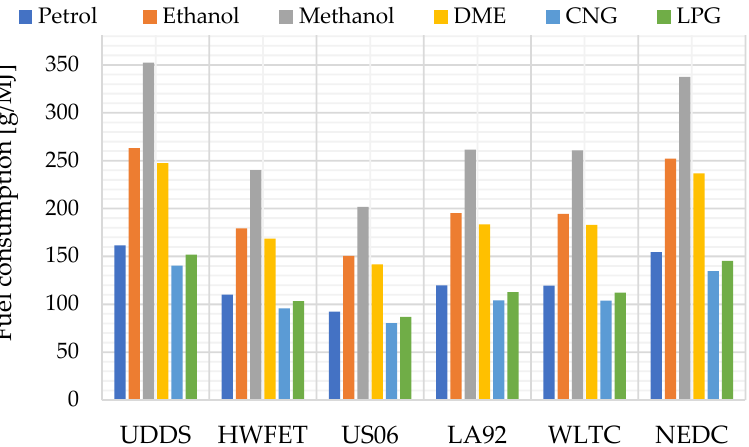
Figure 14. Summary of the final consumption of tested fuels per 1 MJ of travelled road obtained from simulations of the 2018 Toyota Camry LE vehicle for selected road tests.